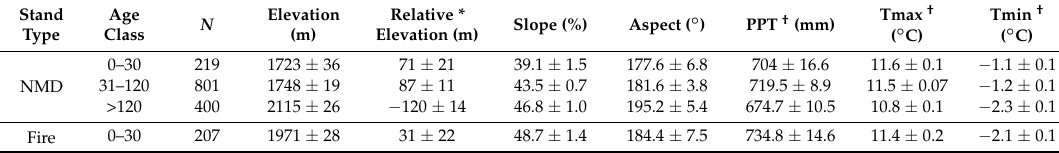
Figure 2. Locations of Forest Inventory and Analysis stands representing interior Douglas-fir ( Pseudotsuga menziesii var. glauca ) forest type used in this study from across the Interior West, USA. Table 1. Mean and standard error of stand environmental characteristics for each disturbance type and development